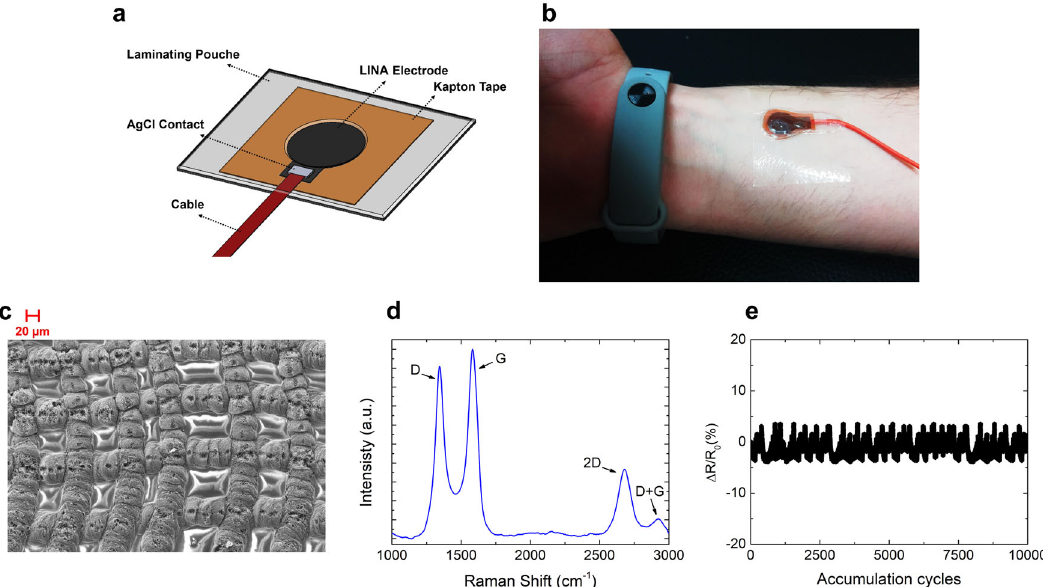
Fig. 1 Electrode fabrication and material characterization. a Schematic of the fl exible electrode. b Flexible electrode attached to the forearm of a person. c SEM-image of the laser patterned surface (scale bar: 20 μ m). The bright areas corresponds to the non-irradiated surface, while the dark ones are that of laser-induced nanographene aggregate. d Raman spectrum of the laser-induced porous nanographene aggregates. e Percentage of change in resistance ( R / R 0 (%)) for a increasing number of bending cycles, being R 0 the initial resistance and R the resistance measured after each bending